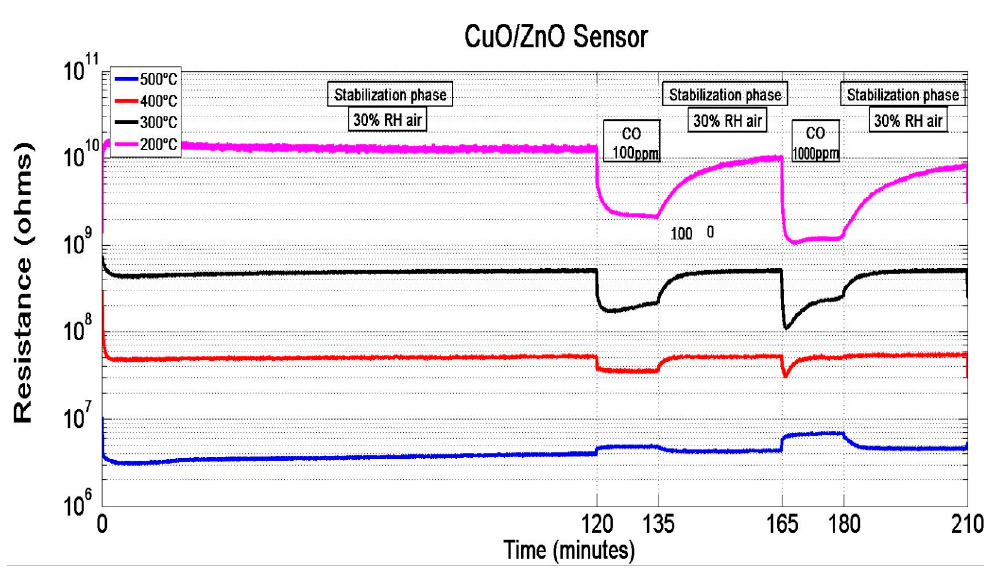
Figure 3. Responses of CuO 75% /ZnO 25% gas sensor at different operating